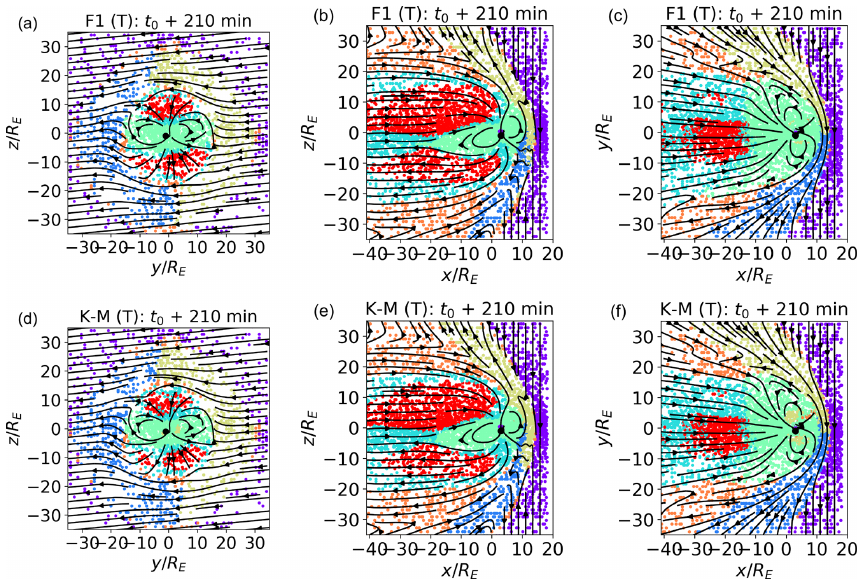
Figure 7. Unsupervised k-means classification of trained SOM nodes, with k = 7 (a–c) , and pure k-means classification, with k = 7 (d–f) . The feature set is F1, and the time is t 0 + 210min. The training (T) data set is depicted.